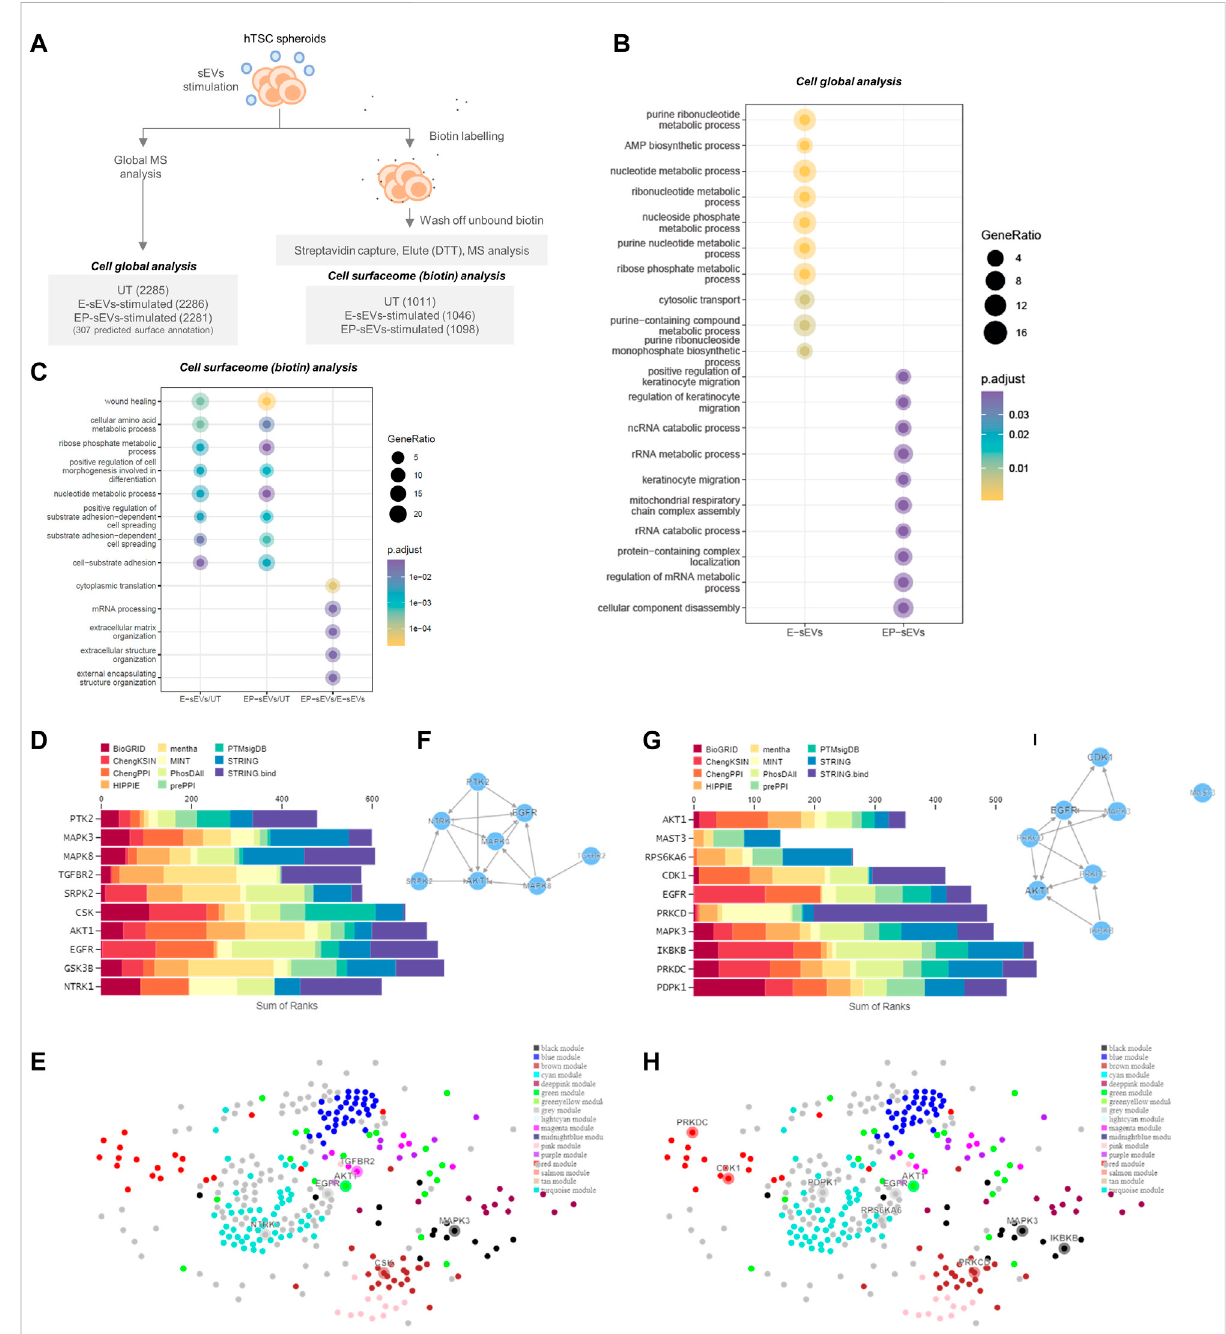
Endometrial small extracellular vesicles reprogram trophoblast proteome towards invasive phenotype. (A) Experimental work fl ow of hTSC proteome remodeling following treatment with E-/EP-sEV at global and cell surface proteome, with quanti fi ed proteins for each group shown. (B) Gene Ontology enrichment analysis (DAVID) for biological processes enriched in TSCs treated with either EP-sEVs or E-sEVs. (C) Gene Ontology enrichment analysis (DAVID) for biological processes enriched in proteins abundant in TSC cell surfaceome following treatment with E-/EP- sEVs (and UT). (D – H) Kinase Enrichment Analysis 3 (KEA3) (Kuleshov et al., 2021) was employed to identify upstream kinases whose substrates are overrepresented indifferentiallyabundantproteins.ForhigherabundantproteinsfollowingEP-sEVs treatment (D) barchartdisplaysthetop-ranking kinases across different libraries whose putative substrates are overrepresented (E) Human kinome regulatory network highlighting the top-ranked kinases with all kinases labelled by WGCNA modules and (F) Kinase co-regulatory networks constructed from top-ranked kinase enrichment results forvariouskinase-substrateinteractionlibraries. Forhigherabundantsurfaceproteins infollowingEP-sEVs treatment, (G) barchart displaysthetop- rankingkinasesacrossdifferentlibrarieswhoseputativesubstratesareoverrepresented, (H) Humankinomeregulatorynetworkhighlightingthetop- ranked kinases with all kinases labelled by WGCNA modules and (I) Kinase co-regulatory networks constructed from top-ranked kinase enrichment results for various kinase-substrate interaction libraries.